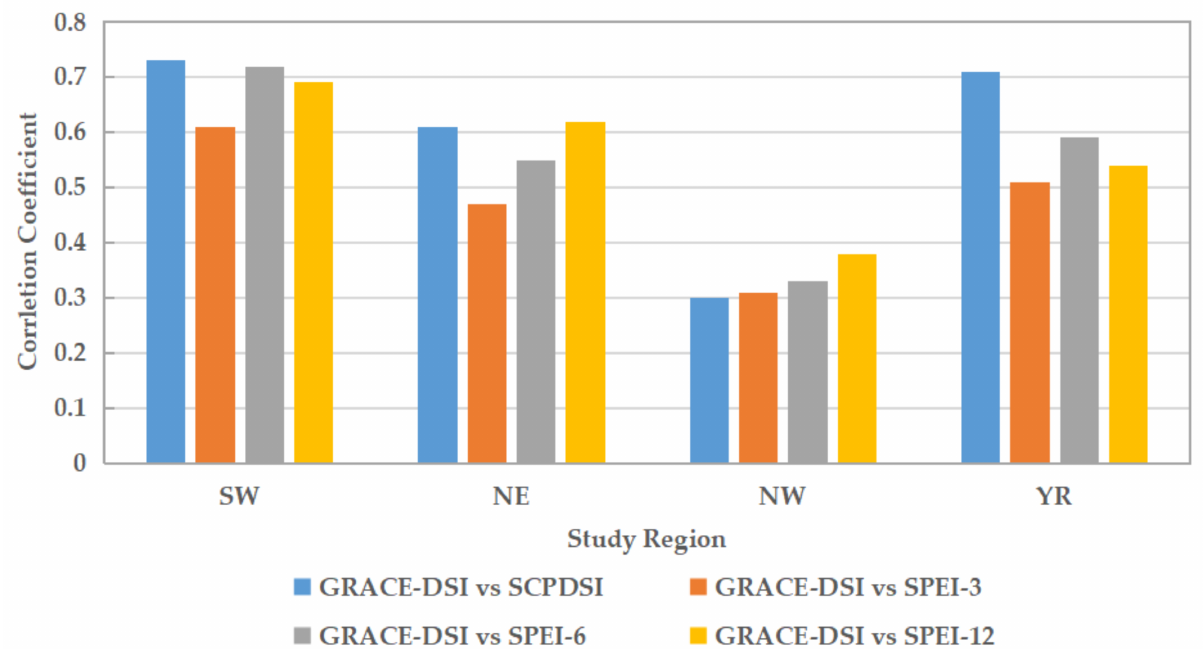
Figure 3. The correlation coefficient between GRACE-DSI and SCPDSI, SPEI-3, SPEI-6, and